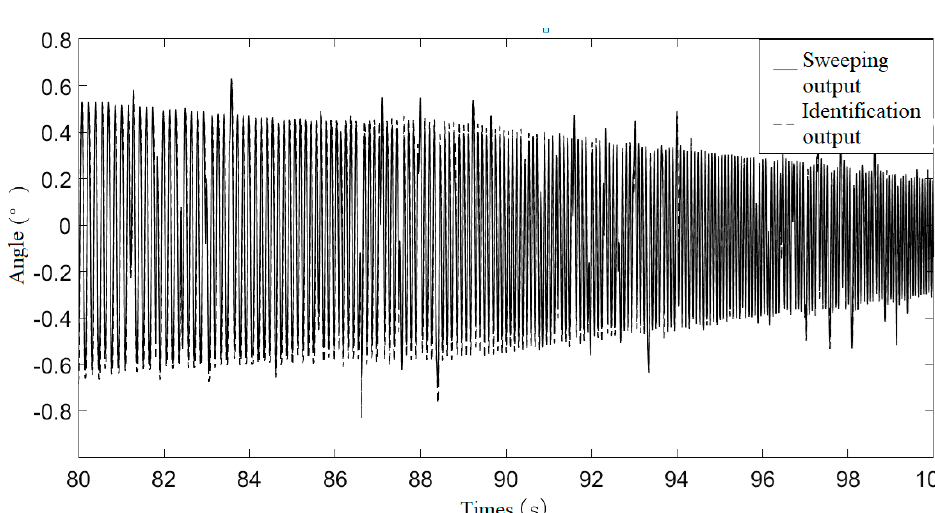
Figure 3. Comparison diagram of verification section.